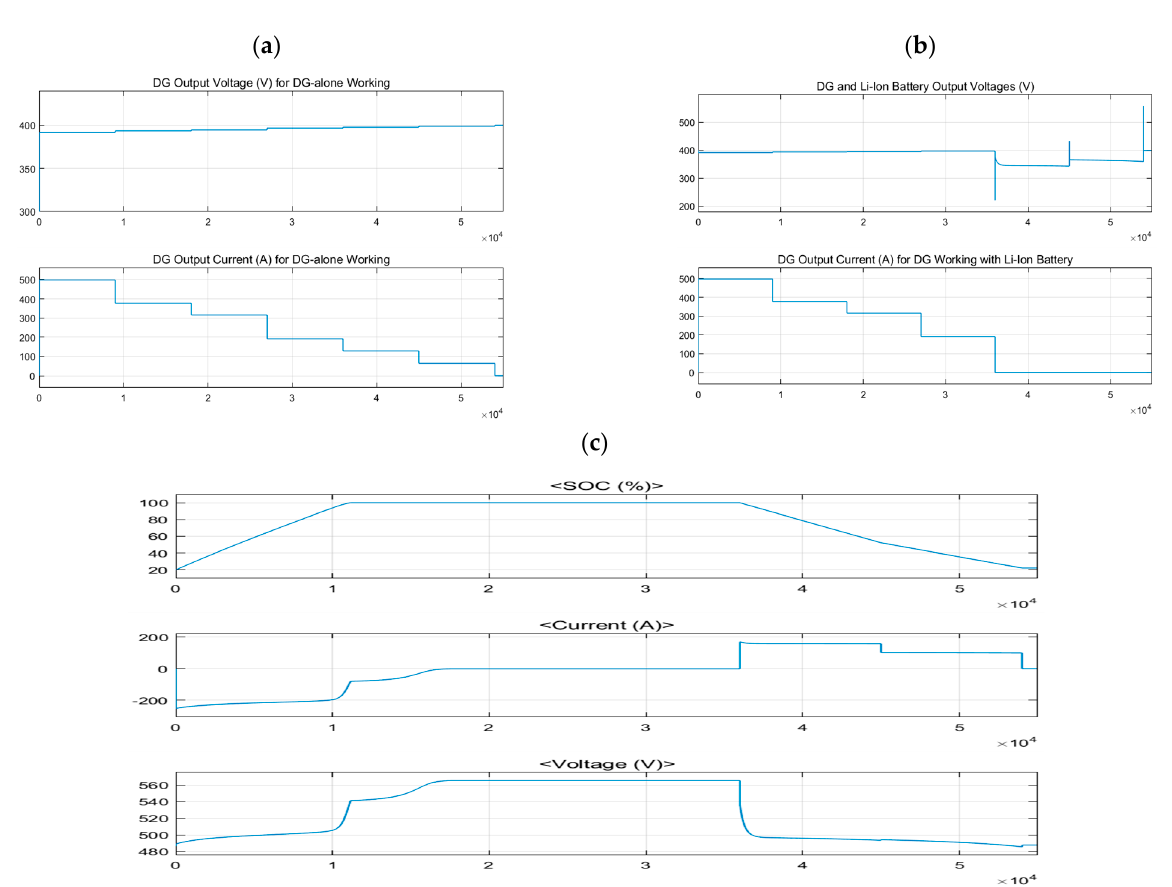
Figure 5. Scope outputs from blocks for a DG working without/with Li-ion battery: ( a ) DG Output Voltage and Current for DG-alone Working; ( b ) DG Output Voltage and Current for DG Working with Li-Ion Battery; ( c ) The Battery SOC, Current and Voltage values.